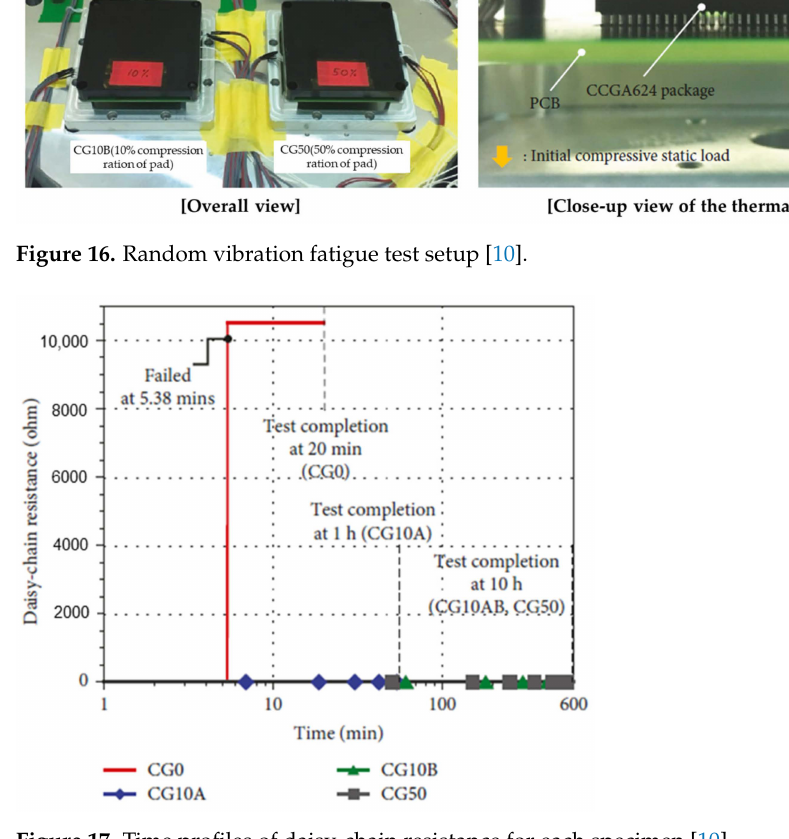
Figure 17. Time profiles of daisy-chain resistance for each specimen